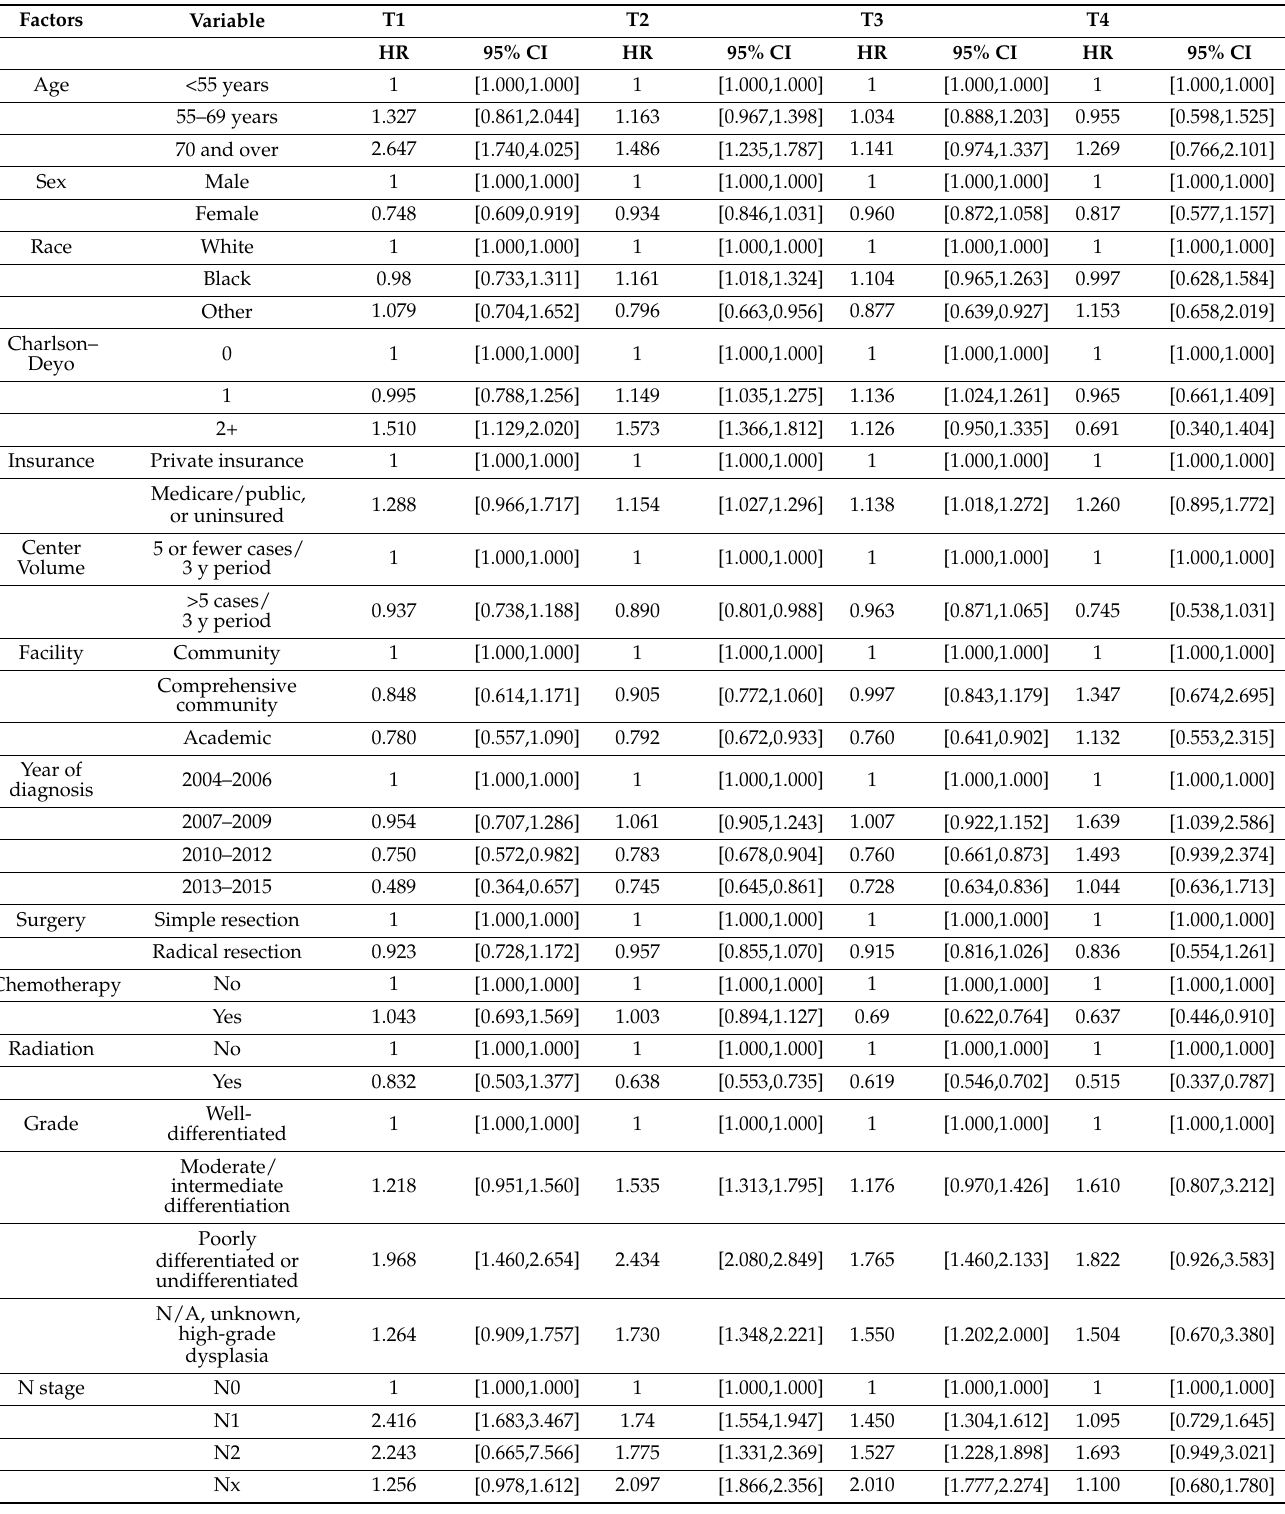
Table 4. Factors associated with risk of death in GBC patients stratified by AJCC 8th T-stage